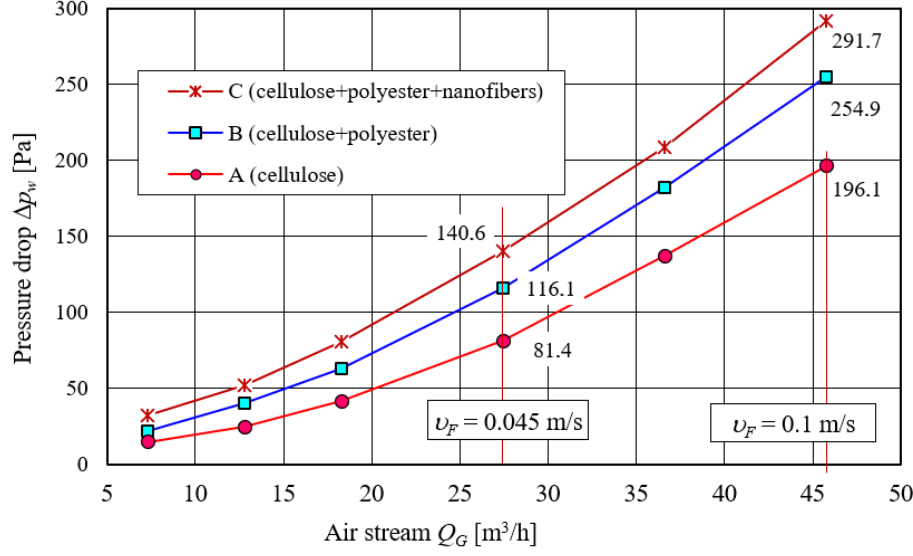
Figure 8. Flow characteristics Δ p w = f ( Q G ) of cartridges with filter materials A, B, and C before testing with test dust.